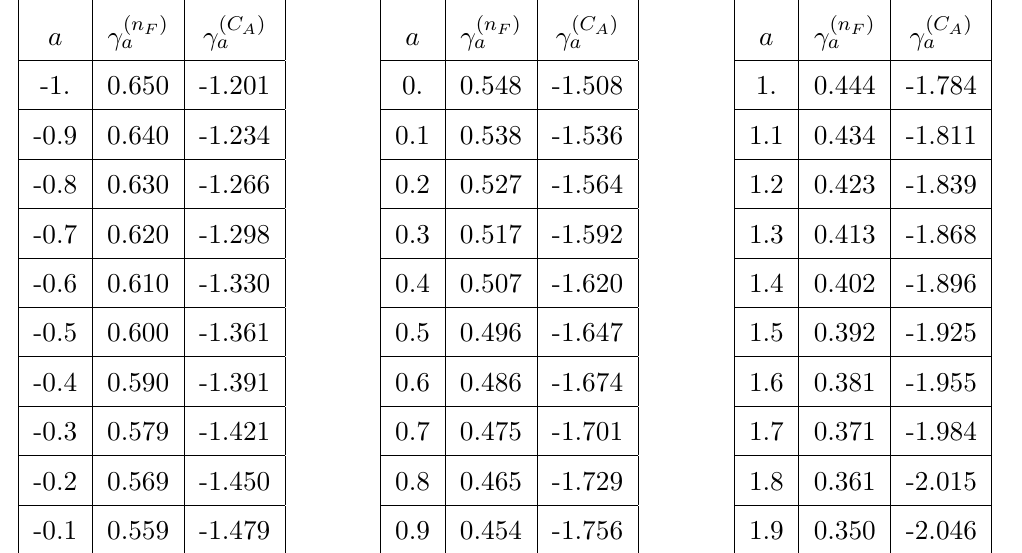
Table 1 . Full numerical values for the functions γ ( n F ) a and γ ( C A ) a for different angularities corre- sponding to the parameter a , contributing to the soft anomalous dimensions of eq. (6.19). The values for γ ( n F ) are rounded to the nearest 0.001, while for γ ( C A ) a most ± 1 in the last